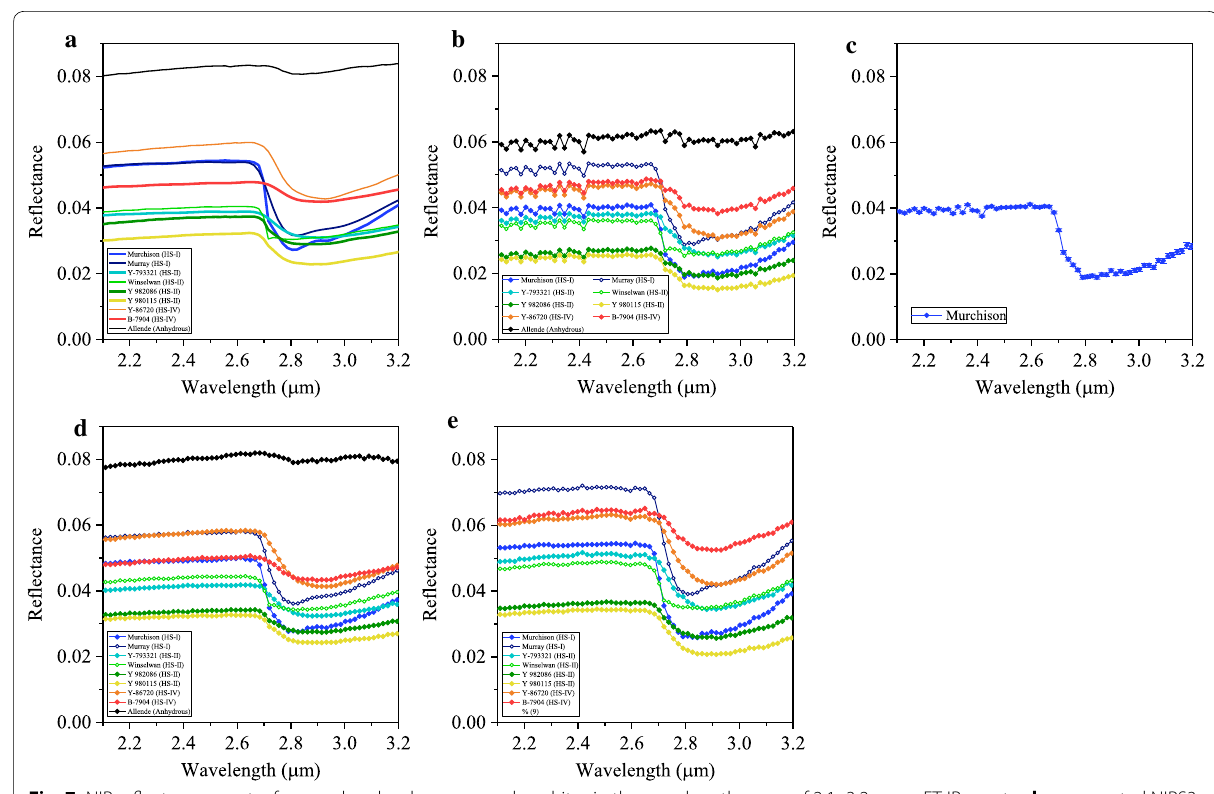
those two correction methods can also be minimized. Figure 11 plots the D 2.90 values and the D 2.76 / D 2.90 ratios after the D 2.90 values of NIRS3 data were corrected by the correlation lines (Fig. 10d). The D 2.90 values represent the depth of 3-μm band because 2.90 μm is almost the center of the band. Note that D 2.90 values used in D 2.76 / D 2.90 ratio on the vertical axis were not corrected. There are four clusters in this figure: HS-I aggregated in the upper right area, Jbilet Winselwan plotted in the left side of the HS-I area, B-7904 plotted in the lower left area, and other chondrites aggregated in the middle of the dia- gram. The data are not linearly distributed unlike in the case of Fig. 9, indicating that the distribution cannot be explained only by the effect of normal heating.